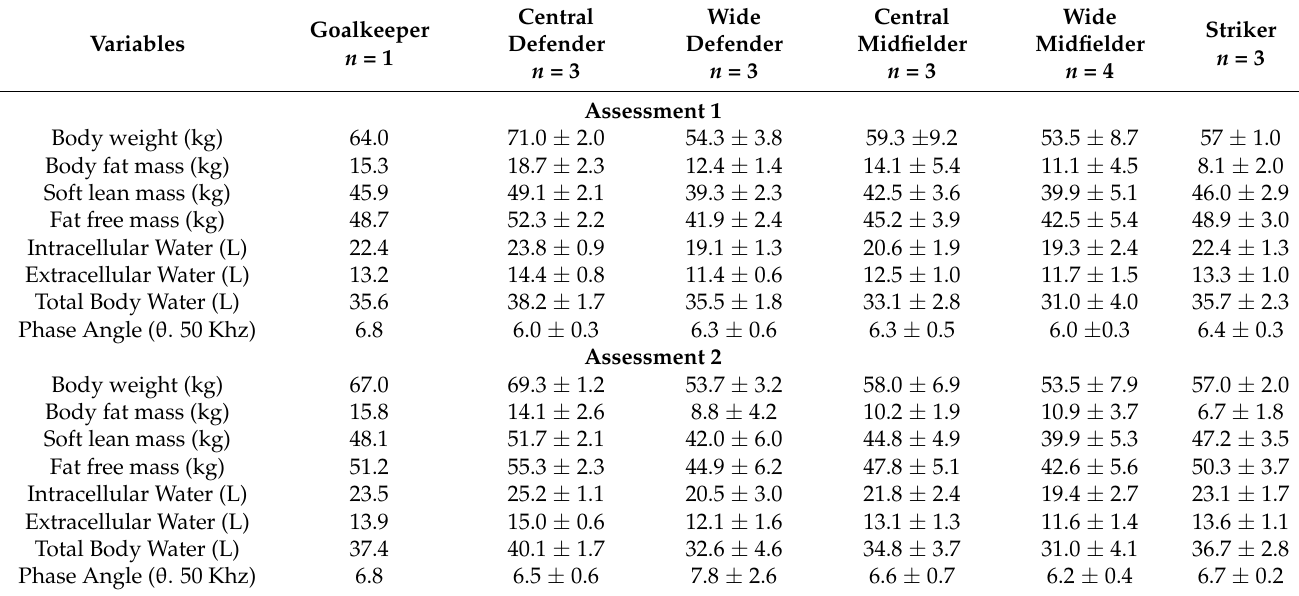
Table 2. Participant characteristics by player position in the three